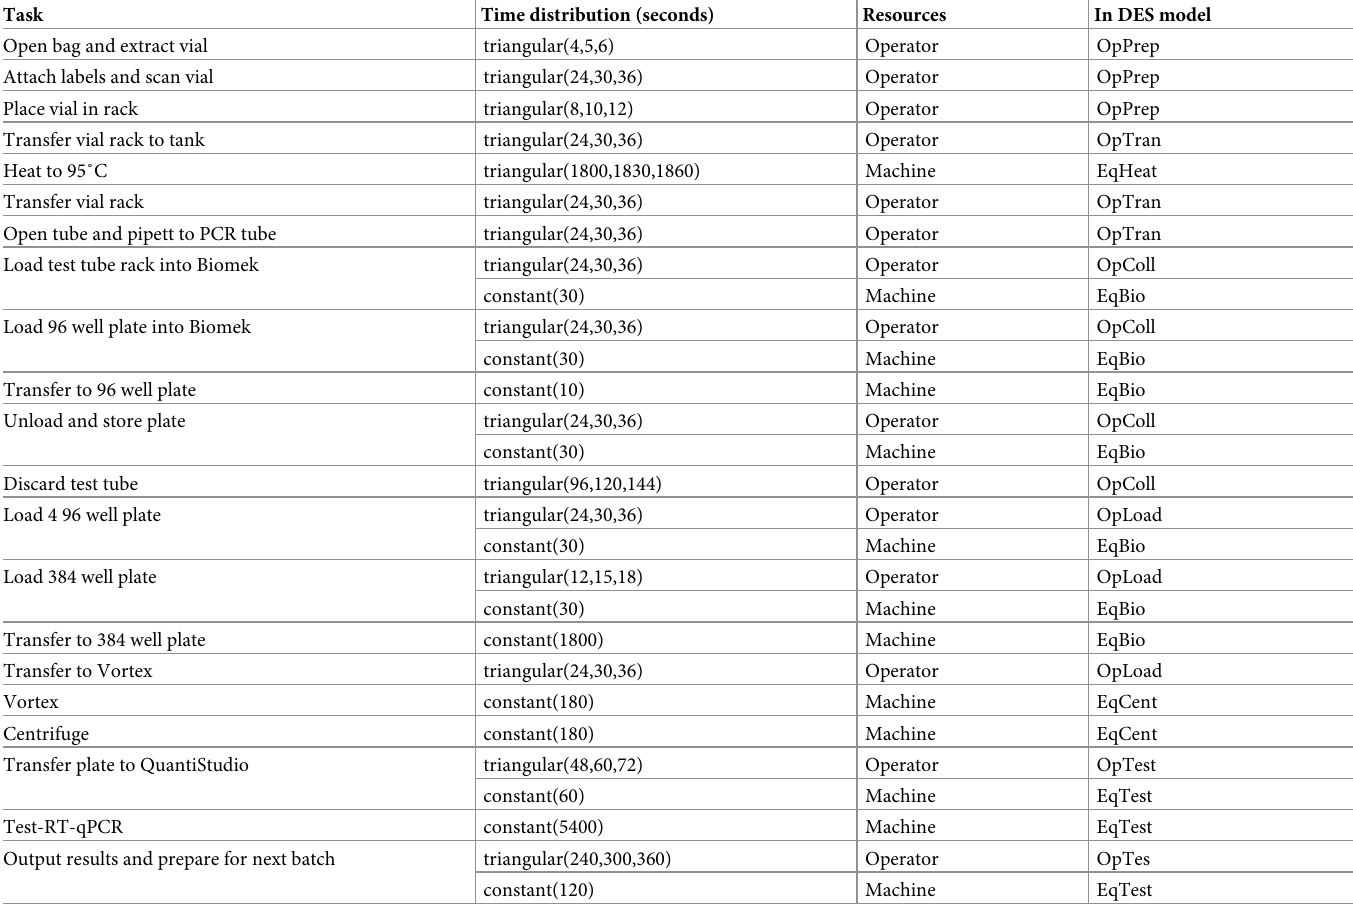
Table 2. Time distribution and resources allocation in the DES